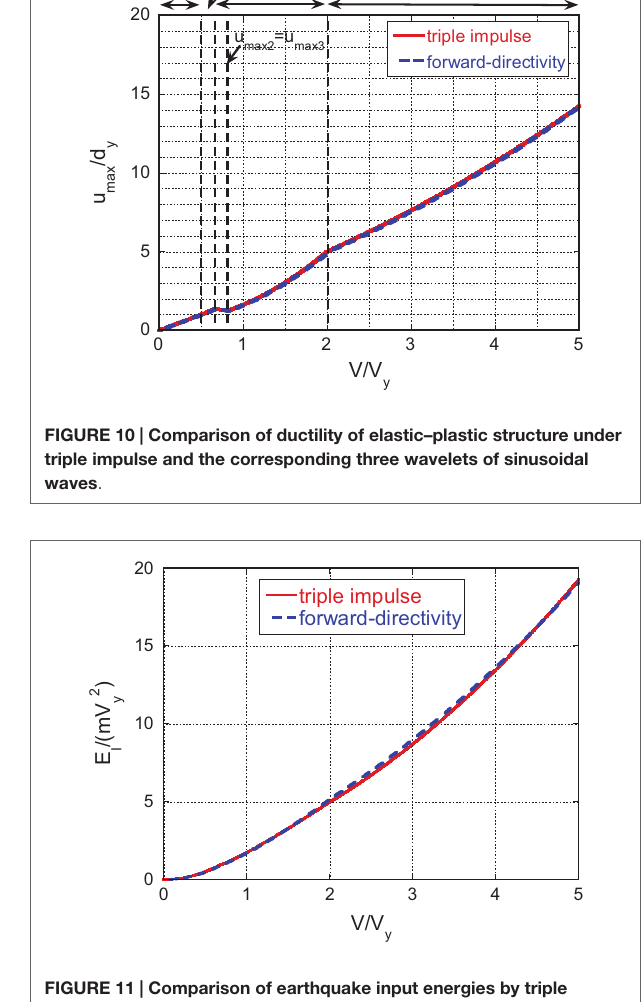
FigUre 11 | comparison of earthquake input energies by triple impulse and the corresponding three wavelets of sinusoidal waves .